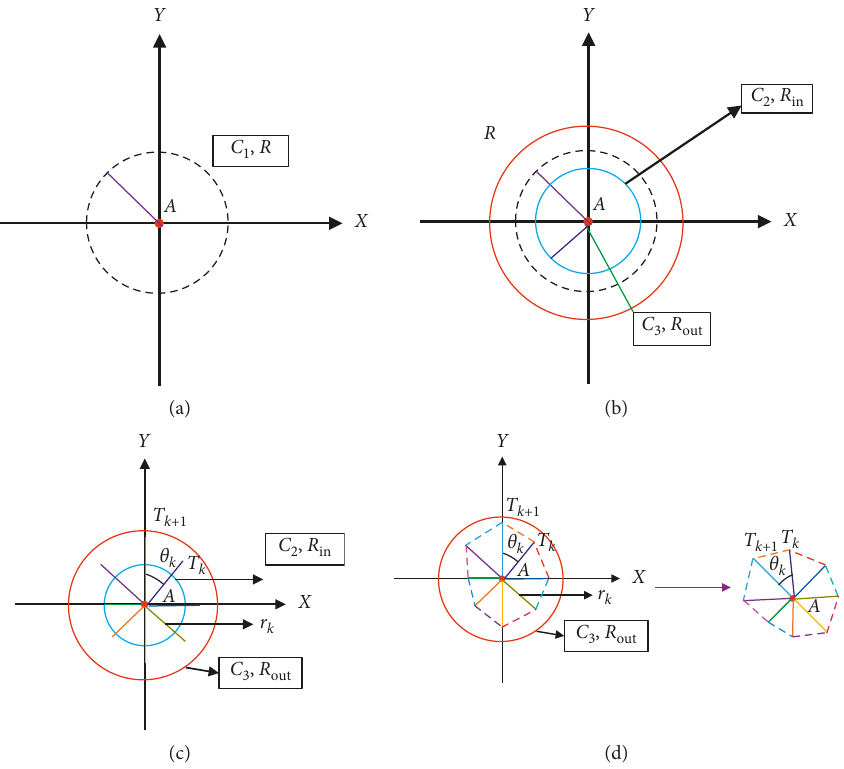
Figure 2: Schematic of the process for generating irregular polygons. (a) Generating initial body. (b) Generating characteristic circle. (c) Determining vertices of the irregular polygons. (d) Generating irregular